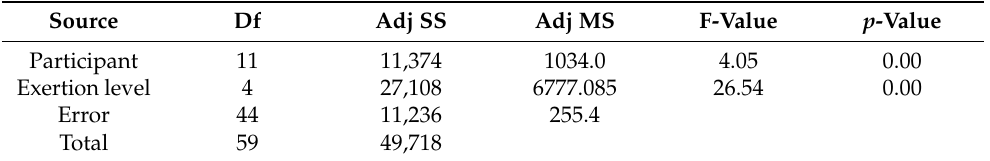
Table 3. ANOVA results for the effect of exertion level on the exerted arm force (N). D: degree of freedom, MS: mean sum of squares, and SS: sum of squares.